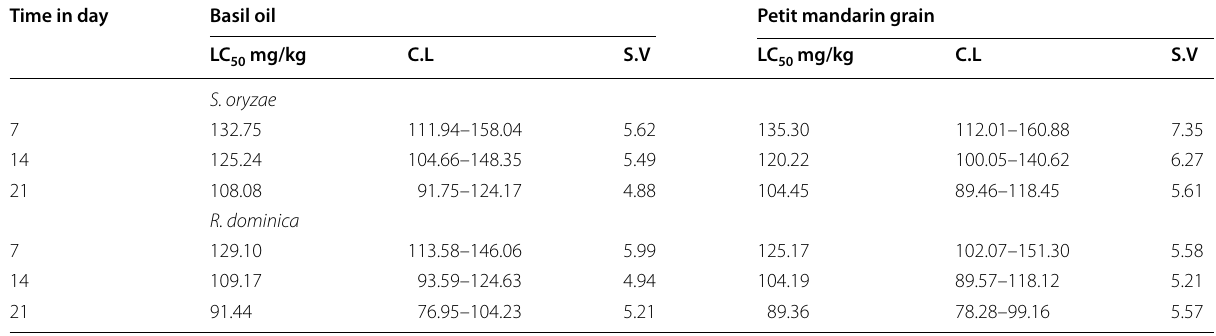
Table 1 Toxicity of the tested plant oils against adults of and R. dominica at the indicated times post‑treatment Time in day